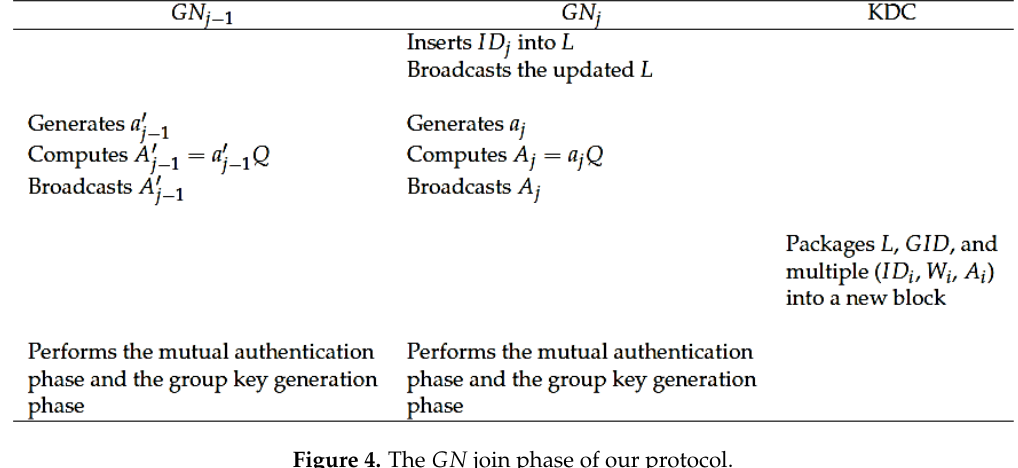
Figure 4. The GN join phase of our protocol.